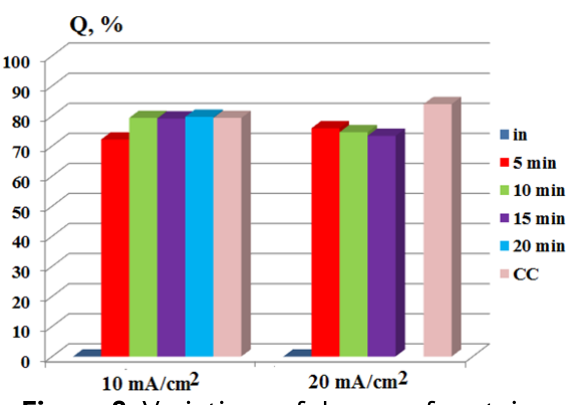
Figure 8. Variations of degree of proteins isolation in PMCs (Q, %), at different times,